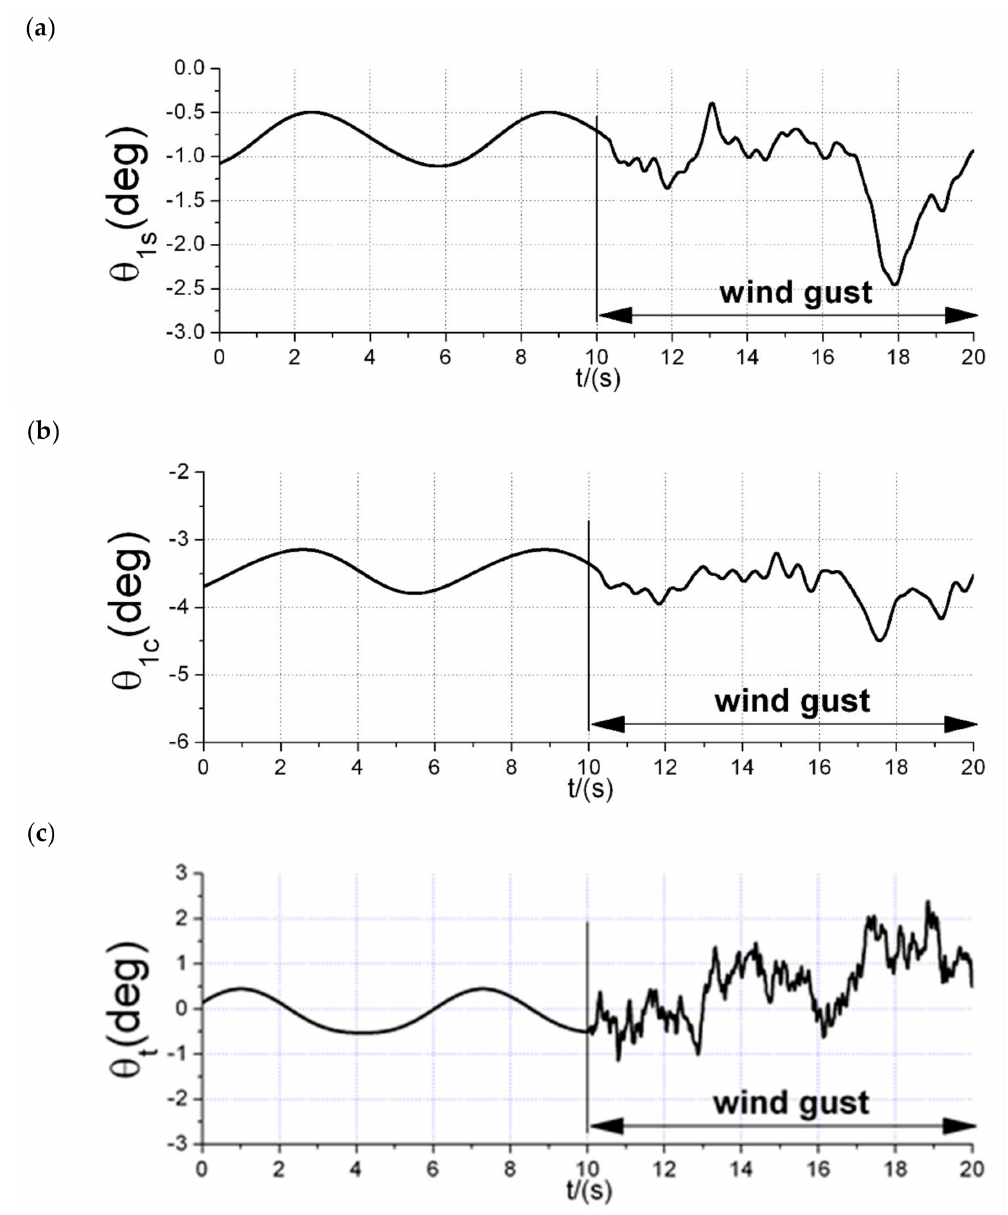
Figure 4. Control inputs without uncertainties. ( a ) Lateral control input; ( b ) longitudinal control input; ( c ) yaw control